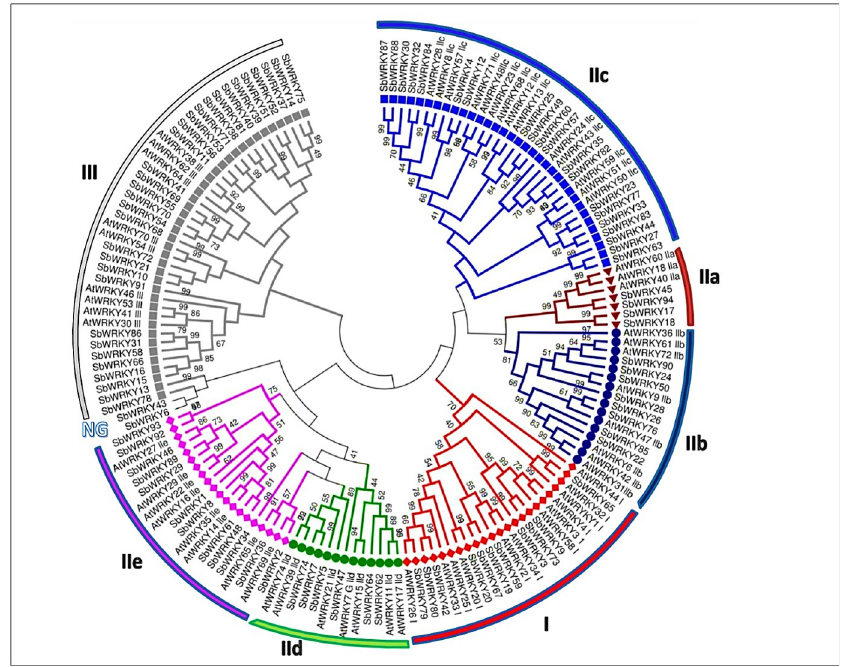
Fig 2. Phylogenetic tree of WRKY members in sorghum and Arabidopsis. Sb WRKY and At WRKY protein sequences were aligned with ClustalW, and a phylogenetic tree was constructed with MEGA7.0 using the neighbour- joining method and 1,000 bootstrap replicates. The members were divided into groups I, II, and III, and group II was further divided into subgroups IIa, IIb, IIc, Ild, and Ile.